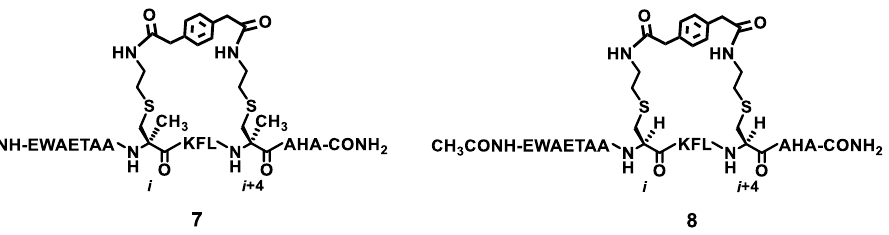
Figure 3. The chemical structures of the stapled peptides 7 and 8 .